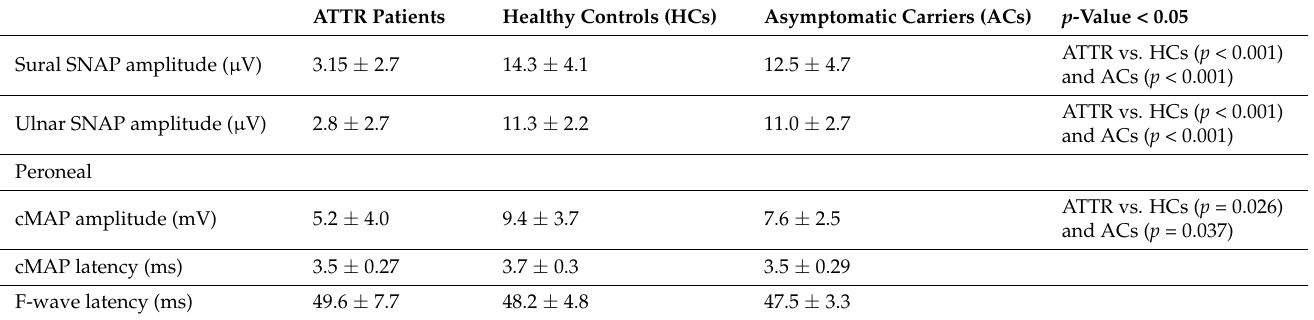
Table 2. Neurophysiologic data from the three participant cohorts. ATTR Patients Healthy Controls (HCs) Asymptomatic Carriers